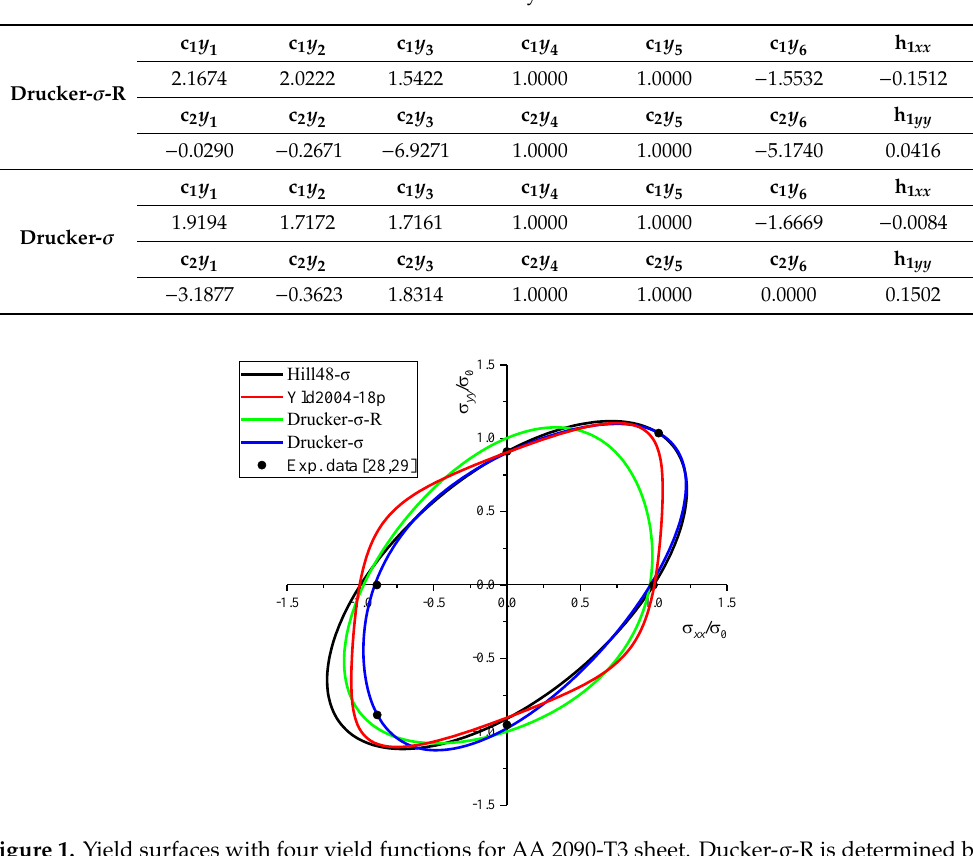
Figure 2. Yield surfaces with four yield functions for AA 2008-T4 sheet. Ducker-σ-R is determined by Equation (40), while Ducker-σ is determined by Equation (41). The biaxial compressive stress shown here is obtained by 